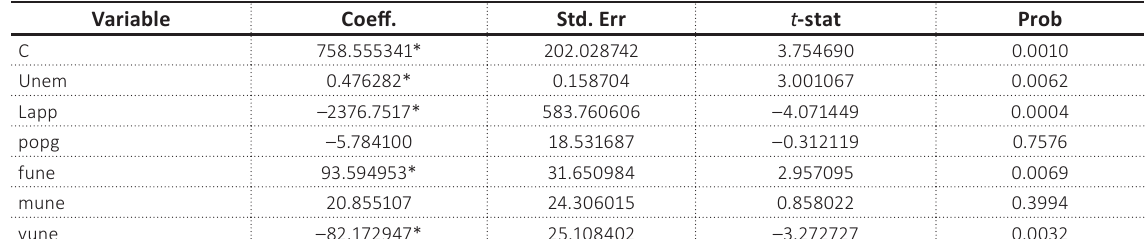
Table 4. ARDL estimates (short-run only)